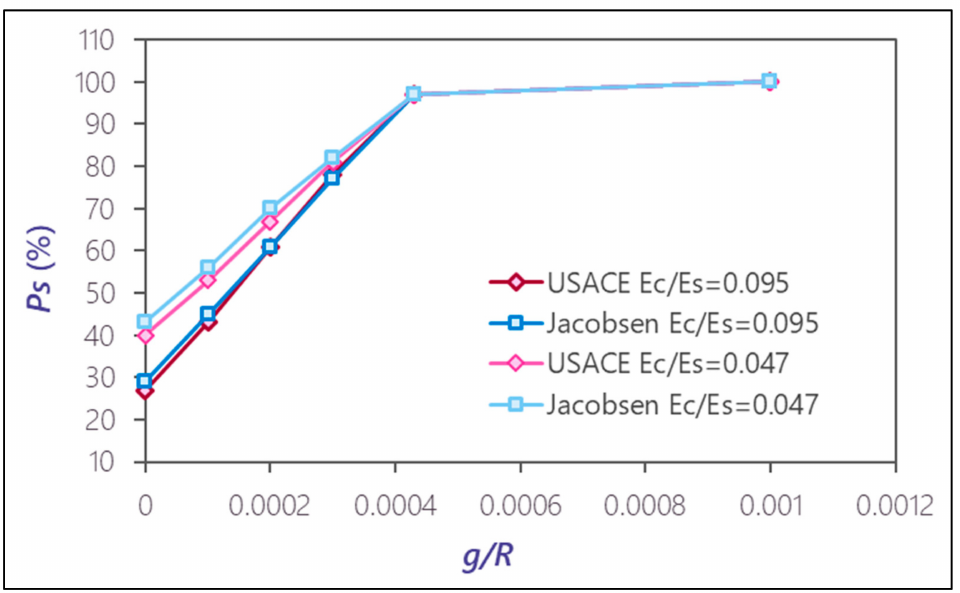
Figure 5. Percentage of internal pressure carried by the steel liner (for D / t = 285.7 and Rfis = 4 Rs